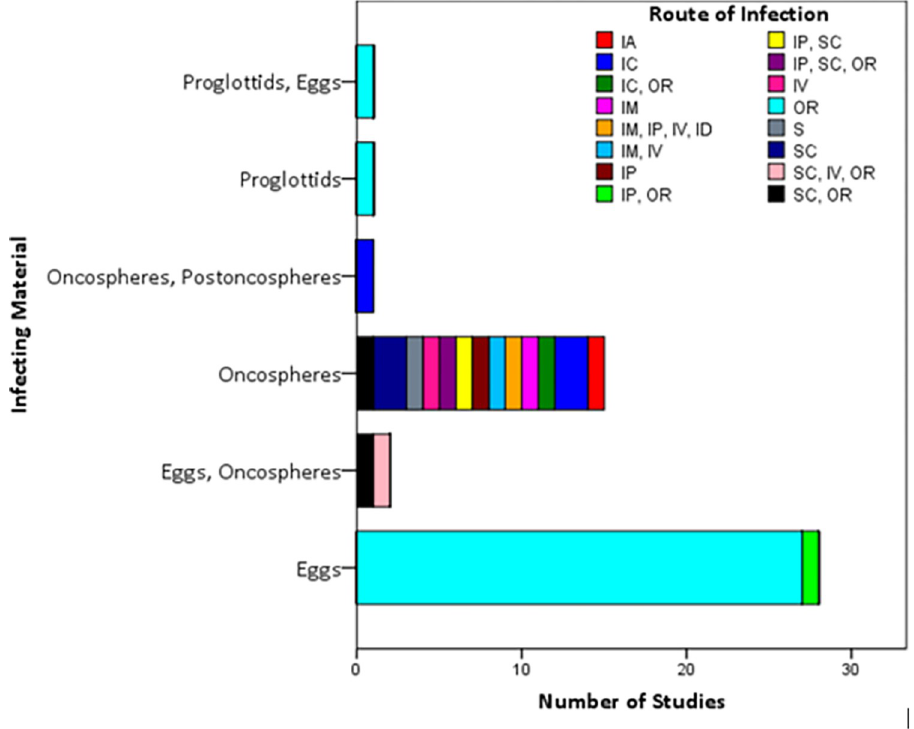
Fig 3. Chart showing route (s) of infection versus material (s) used to infect experimental animals in individual studies. OR = oral; IV = intravenous; SC = subcutaneous; IM = intramuscular; IP = intraperitoneal; IA = intraarterial; IC = intracranial; ID = intraduodenal; S =